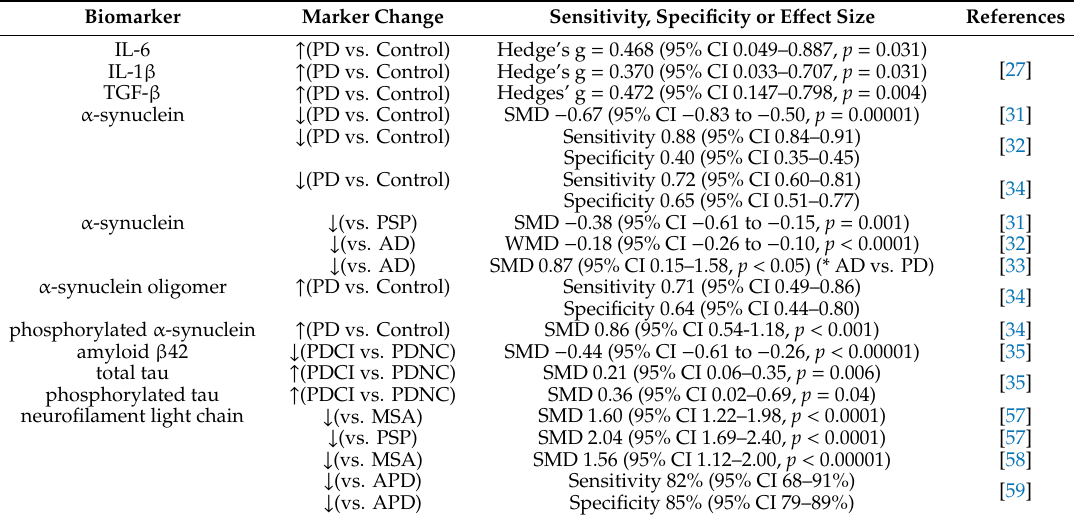
Table 4. Summary of the values of sensitivity, specificity, or the e ff ect size of each marker as reported by the meta-analysis